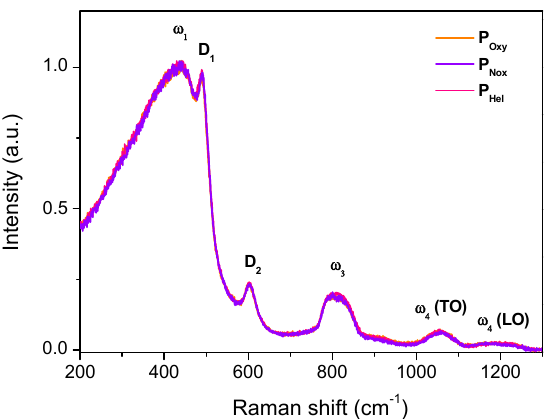
Figure 1. Raman spectra of the three Ce-doped preforms showing the band attribution according to Ref [30].